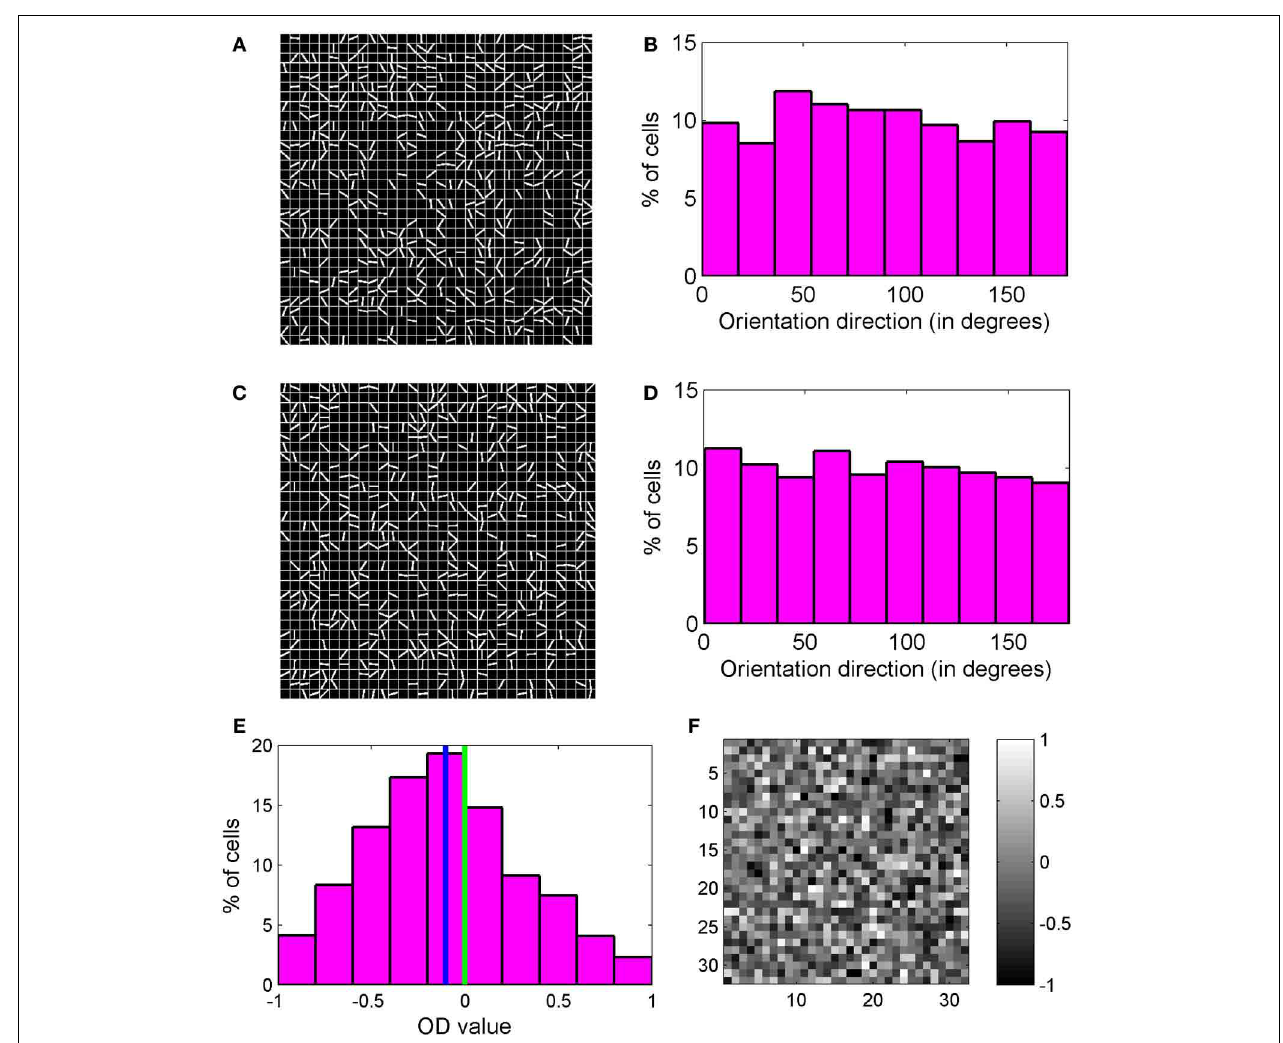
FIGURE 6 | (A,C) Two orientation preference maps for a 32 × 32 section of cortex inside binocular region and monocular region, respectively. The lines depict orientation preference for cells. For cells that are not orientation tuned, no line is shown. We observe a salt and pepper orientation preference map. (B) Orientation preference histogram for